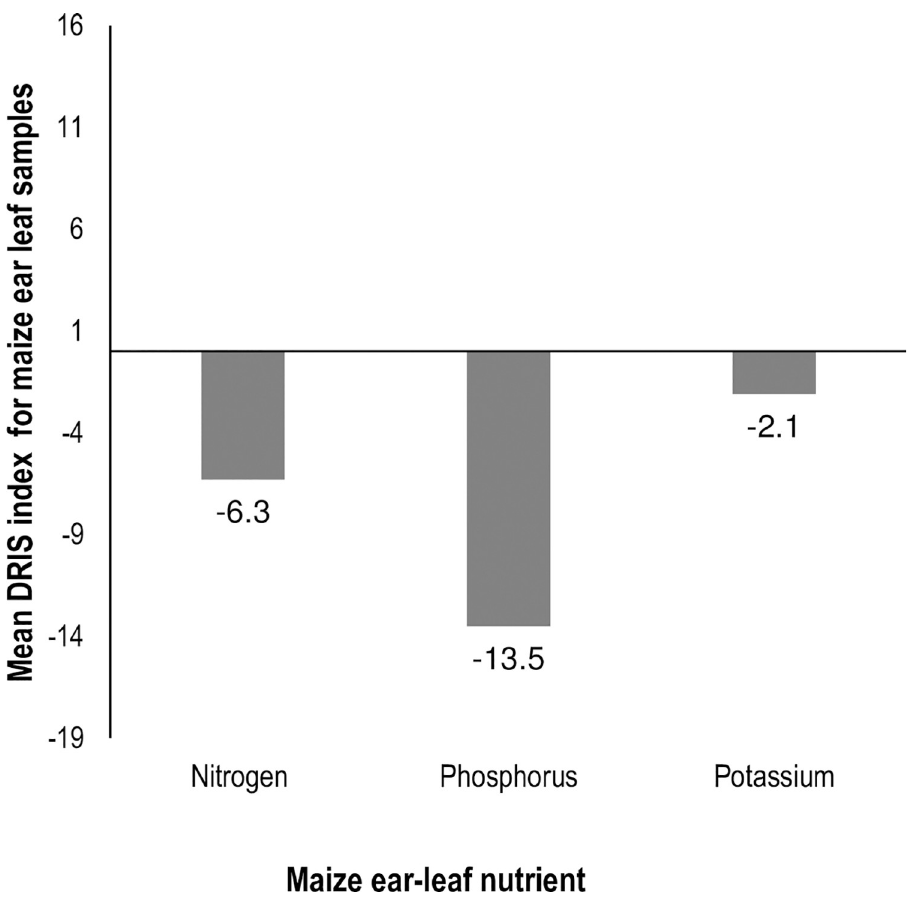
Fig 8. Mean DRIS indices for nitrogen, phosphorus and potassium for maize fields across the study area.